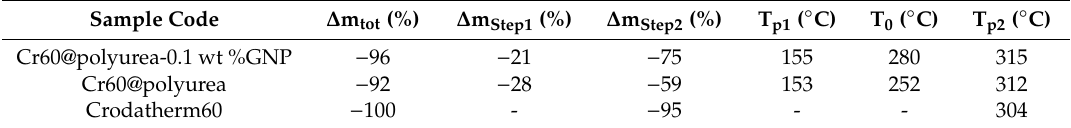
Table 2. Thermogravimetric analysis data of the prepared capsules.